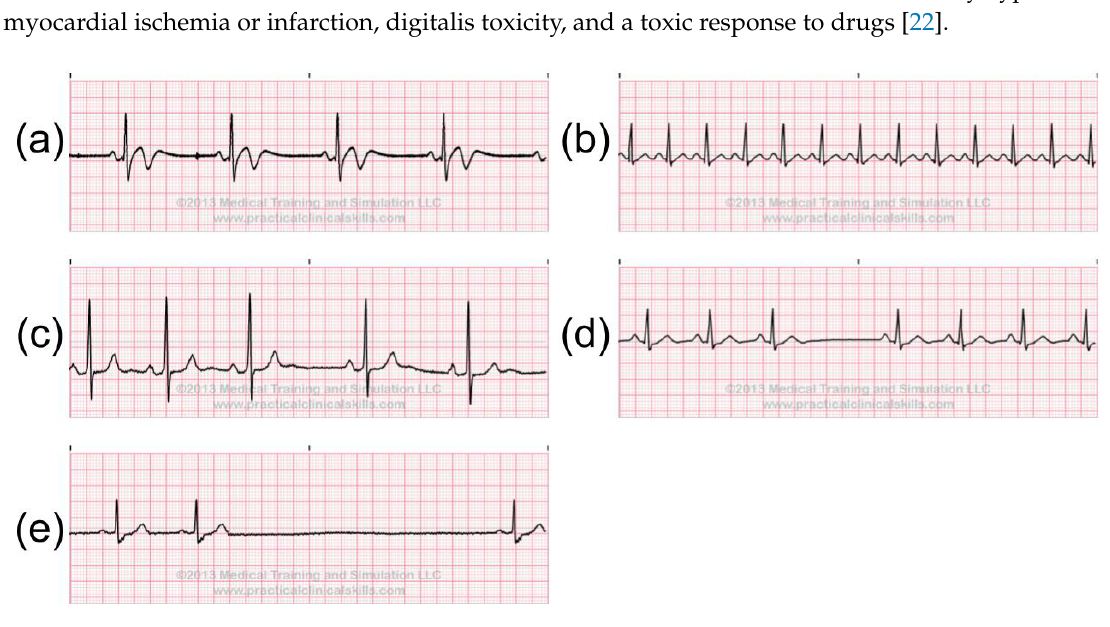
Figure 3. Abnormal sinus rhythms: ( a ) sinus bradycardia, ( b ) sinus tachycardia, ( c ) sinus arrhythmia, ( d ) sinus block, ( e ) sinus arrest